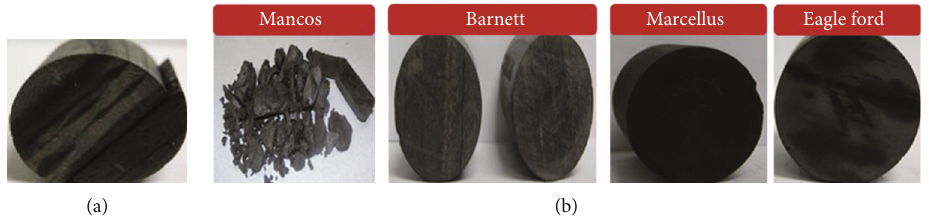
Figure 4: (a) Barnett shale sample after one week of spontaneous imbibition in distilled water [71]. (b) Imbibition testing results from Morsy and Sheng [66].